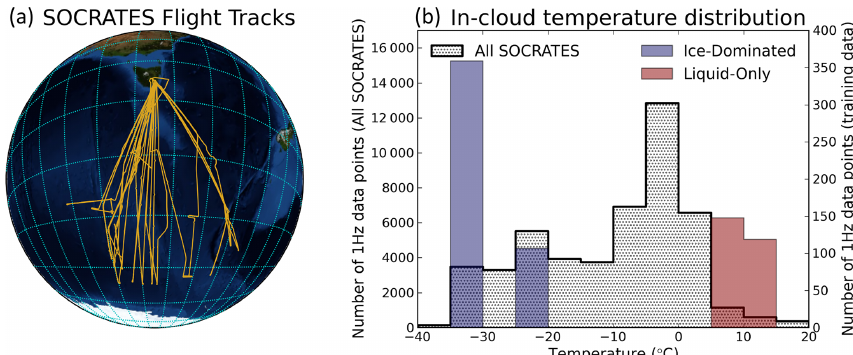
Figure 2. (a) SOCRATES flight tracks from RF01–RF14 (the flights analyzed in this study); (b) 1Hz in-cloud temperature histograms for RF01–RF14 (hatched, left y axis), with ice-dominated data from the TTV set (blue, right y axis) and liquid-only data from the TTV set (red, right y axis). In-cloud data include all samples with at least one particle that satisfy our selection criteria (described in Sect. 2.1).